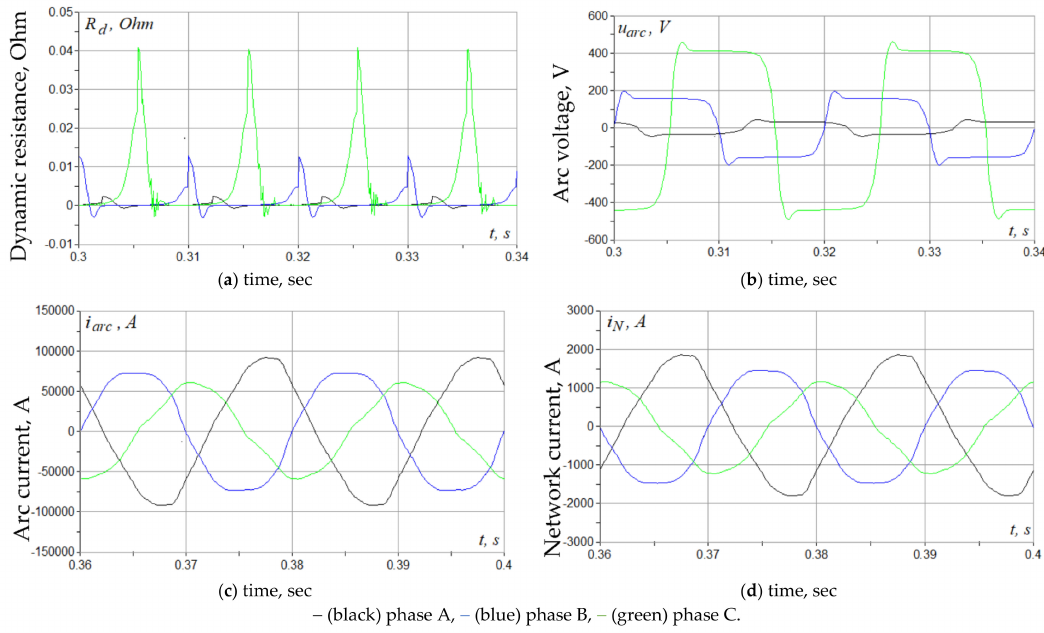
Figure 13. Dynamic arc resistance ( a ), instantaneous values of arc voltages ( b ), instantaneous values of arc currents ( c ), instantaneous values of mains currents ( d ) in steady asymmetric mode for arc length: phase A—2 mm, phase B—8 mm, phase C—20